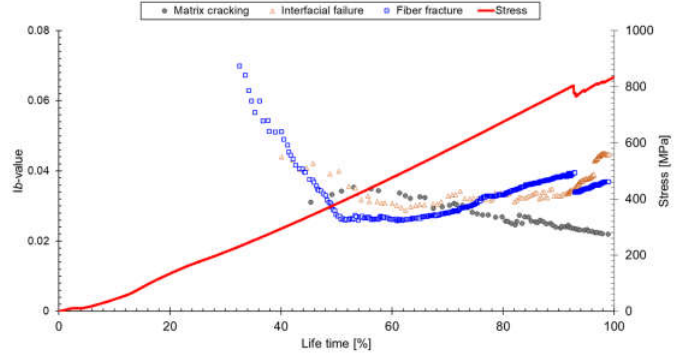
Figure 11. I b -value analysis according to fracture mode.